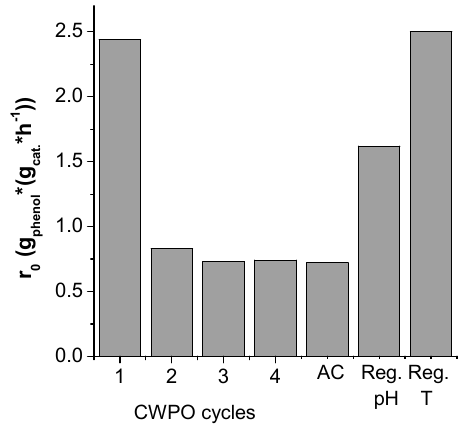
Figure 14. Initial rate of phenol degradation during four consecutives cycles of CWPO using gold supported on activated carbon and after regeneration ([phenol] initial = 5 g/L, [H 2 O 2 ] = 25 g/L, pH = 3.5 and T = 80 °C). Adapted from Domínguez et al. [72].